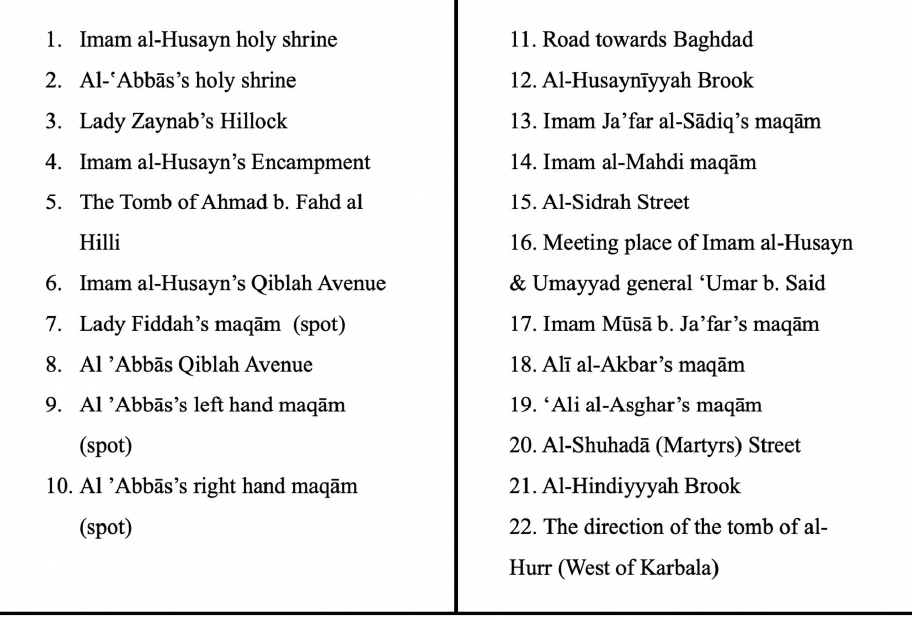
Figure 2. Sacred Spaces and Places Illustrated in Figure 2. Source: Information informing sketch by Muhammad-Reza Fakhr-Rohani provided by the office of the Holy Shrine of Imam al-Husyan 2021.